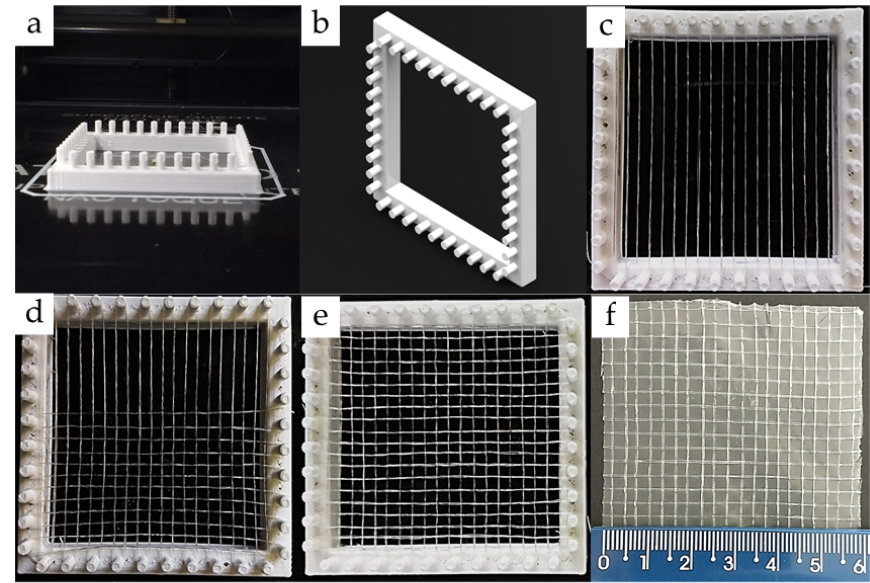
Figure 2. Preparation of the chitosan woven meshes from the weaving of chitosan threads: ( a ) and ( b ) views of the mold made by 3D printing; ( c ) the first plane of threads forming the textile warp; ( d ) secund plane of threads orthogonally inserted into the warp forming a plain weft (1/1); ( e ) chitosan woven meshes obtained by weaving, and ( f ) final chitosan woven mesh coated with a 1.5% chitosan solution.